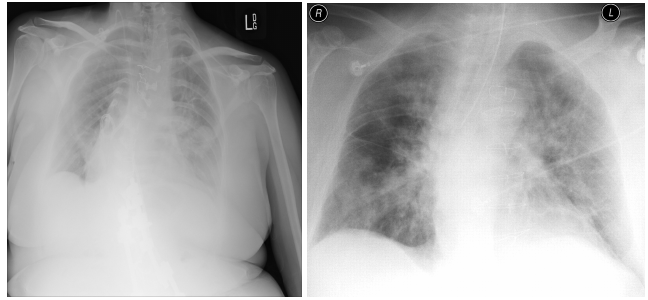
Figure 17. Example of low quality in CIDR and RSNA datasets.